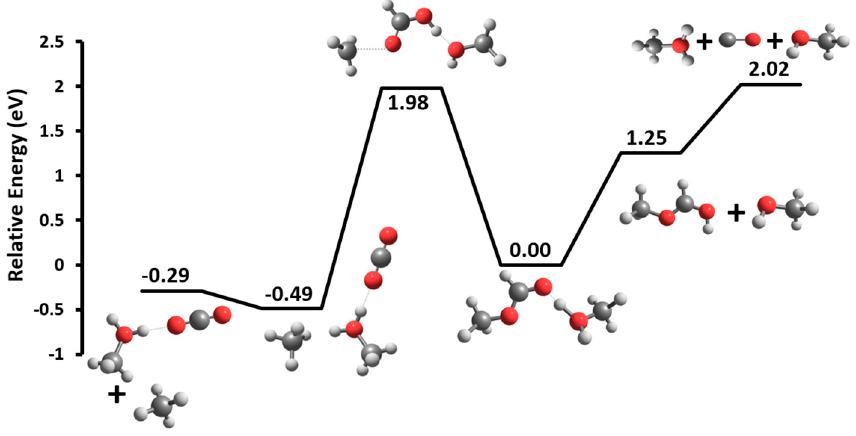
Figure 6. B3LYP/6 ꟷ 311+G(d,p) minimum energy reaction pathways surface for the dissociation of Figure 6. B3LYP/6-311+G(d,p) minimum energy reaction pathways surface for the dissociation of MF(M)H + (m/z 93). MF(M)H + ( m / z 93).